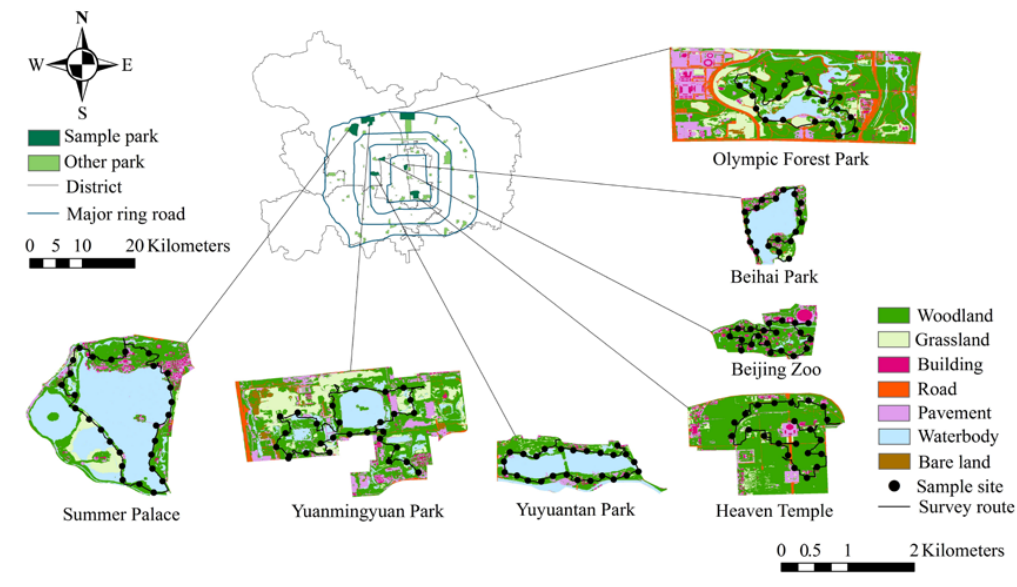
Figure 2. Sample sites of bird census.